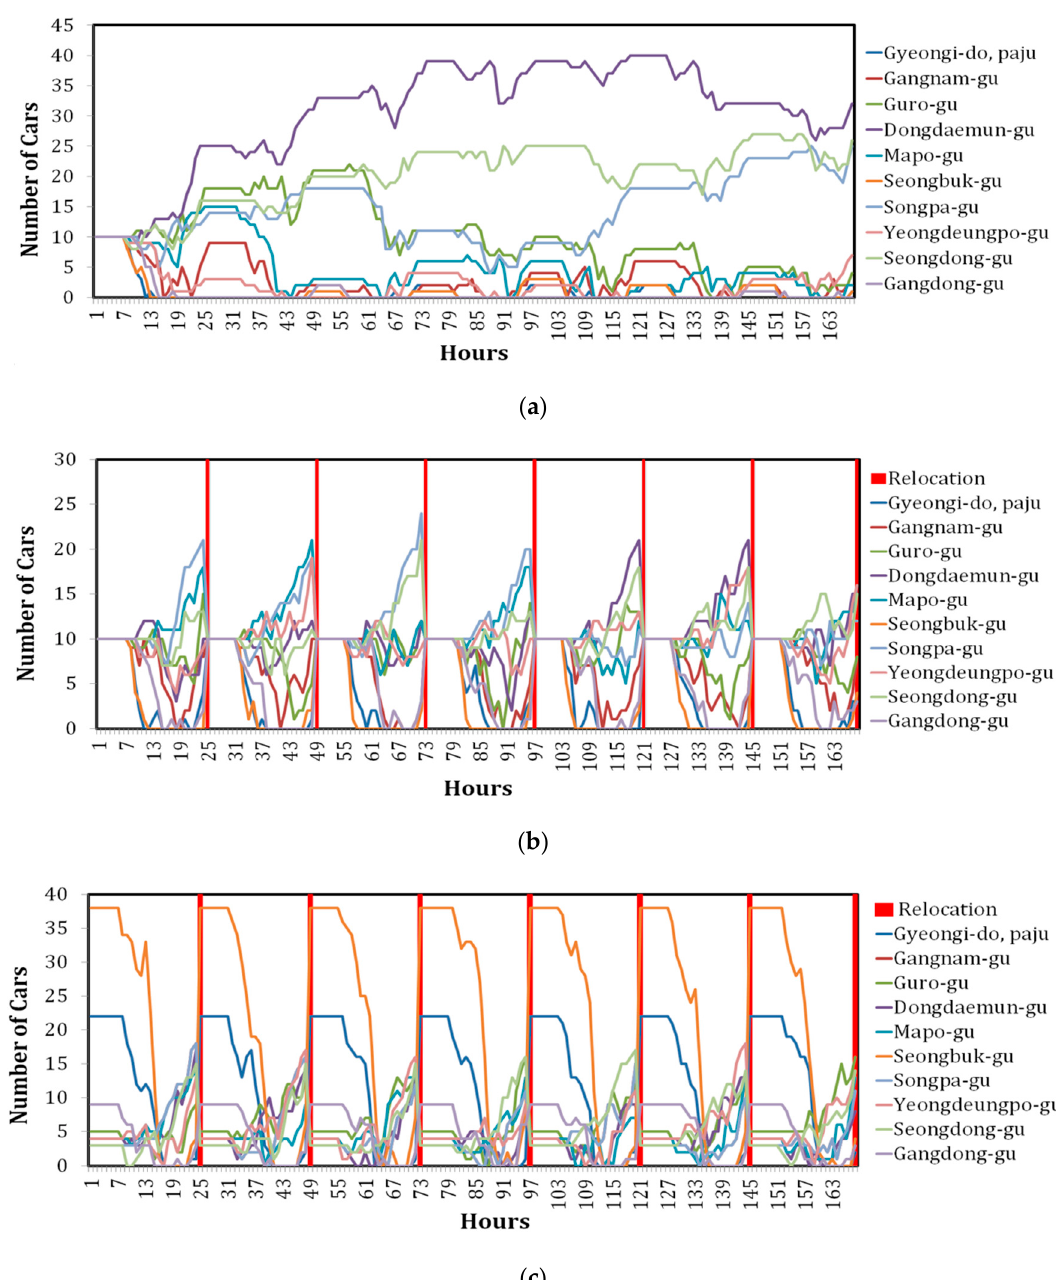
Figure 6. Simulation time history for cars present at each station ( a ) without relocation, ( b ) rebalancing relocation, and ( c ) proposed forecasting relocation.